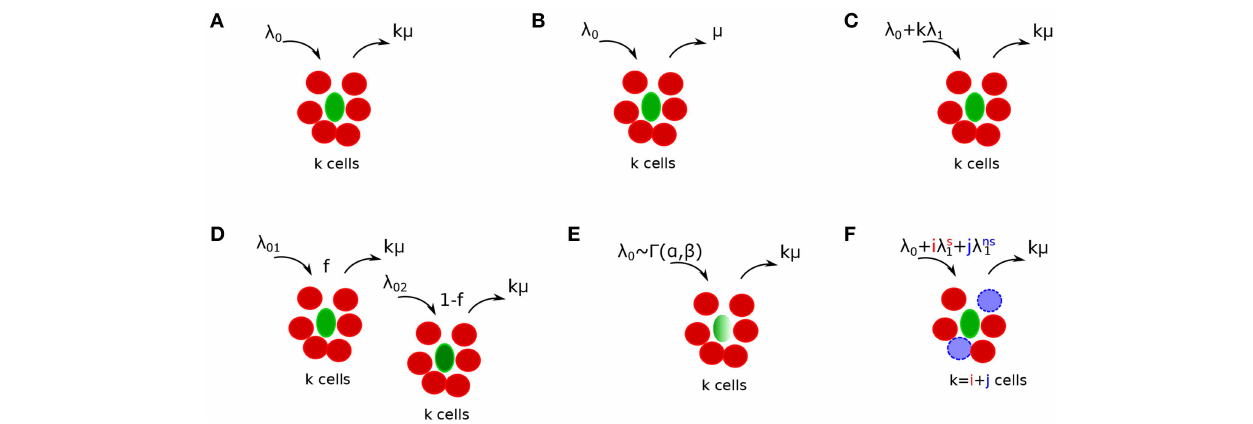
FIGURE 2 | Schematics of alternative mathematical models of T cell cluster formation around Plasmodium yoelii (Py)-infected hepatocytes in mice. Py-specific T cells are labeled by red (disks), T cells of irrelevant specificity are colored by blue (dashed disks), and parasites are labeled by green (ovals). In the models the rate of T cell entry into a cluster is denoted as λ k and rate of exit from the cluster is denoted as µ k . Mathematical models include a random entry/exit (Poisson) model ( A , Equation k µ ), a density-independent (DI) exit model ( B , Equation (5), λ k λ 0 and µ k λ 0 and µ k µ ), a density-dependent (DD) recruitment model ( C , Equation (6), (4), λ k = = = = k λ 1 and µ k k µ ), a “two populations” model in which infected hepatocytes have either of two different “attractiveness” levels determined by λ 01 and λ 02 λ k λ 0 = + = k µ ), a “gamma” model, in which the entry rate into clusters is distributed according to a gamma distribution with α and β being the rate and ( D , Equation (11), µ k = k µ ], and finally a “co-clustering” model, in which clusters are formed by Plasmodium-specific T cells or T cells or shape parameters [ E , Equations (12–15), µ k = i λ s 1 j λ ns 1 and µ k k µ ]. For some of our analyses we characterized the model behavior λ 0 irrelevant specificity (non-specific T cells) [ F , Equations (12–15), λ k = + + = λ k /µ k using the ratio of entry to exit rates denoted as a relative entry rate θ k =